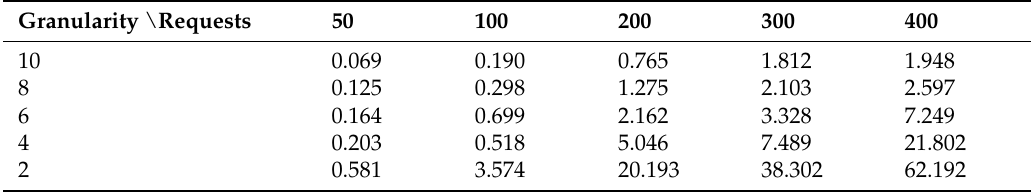
Table 5. Running time for finding solution of SIASP for different scenarios in seconds. It should be noted that this includes scoring and scheduling, not the